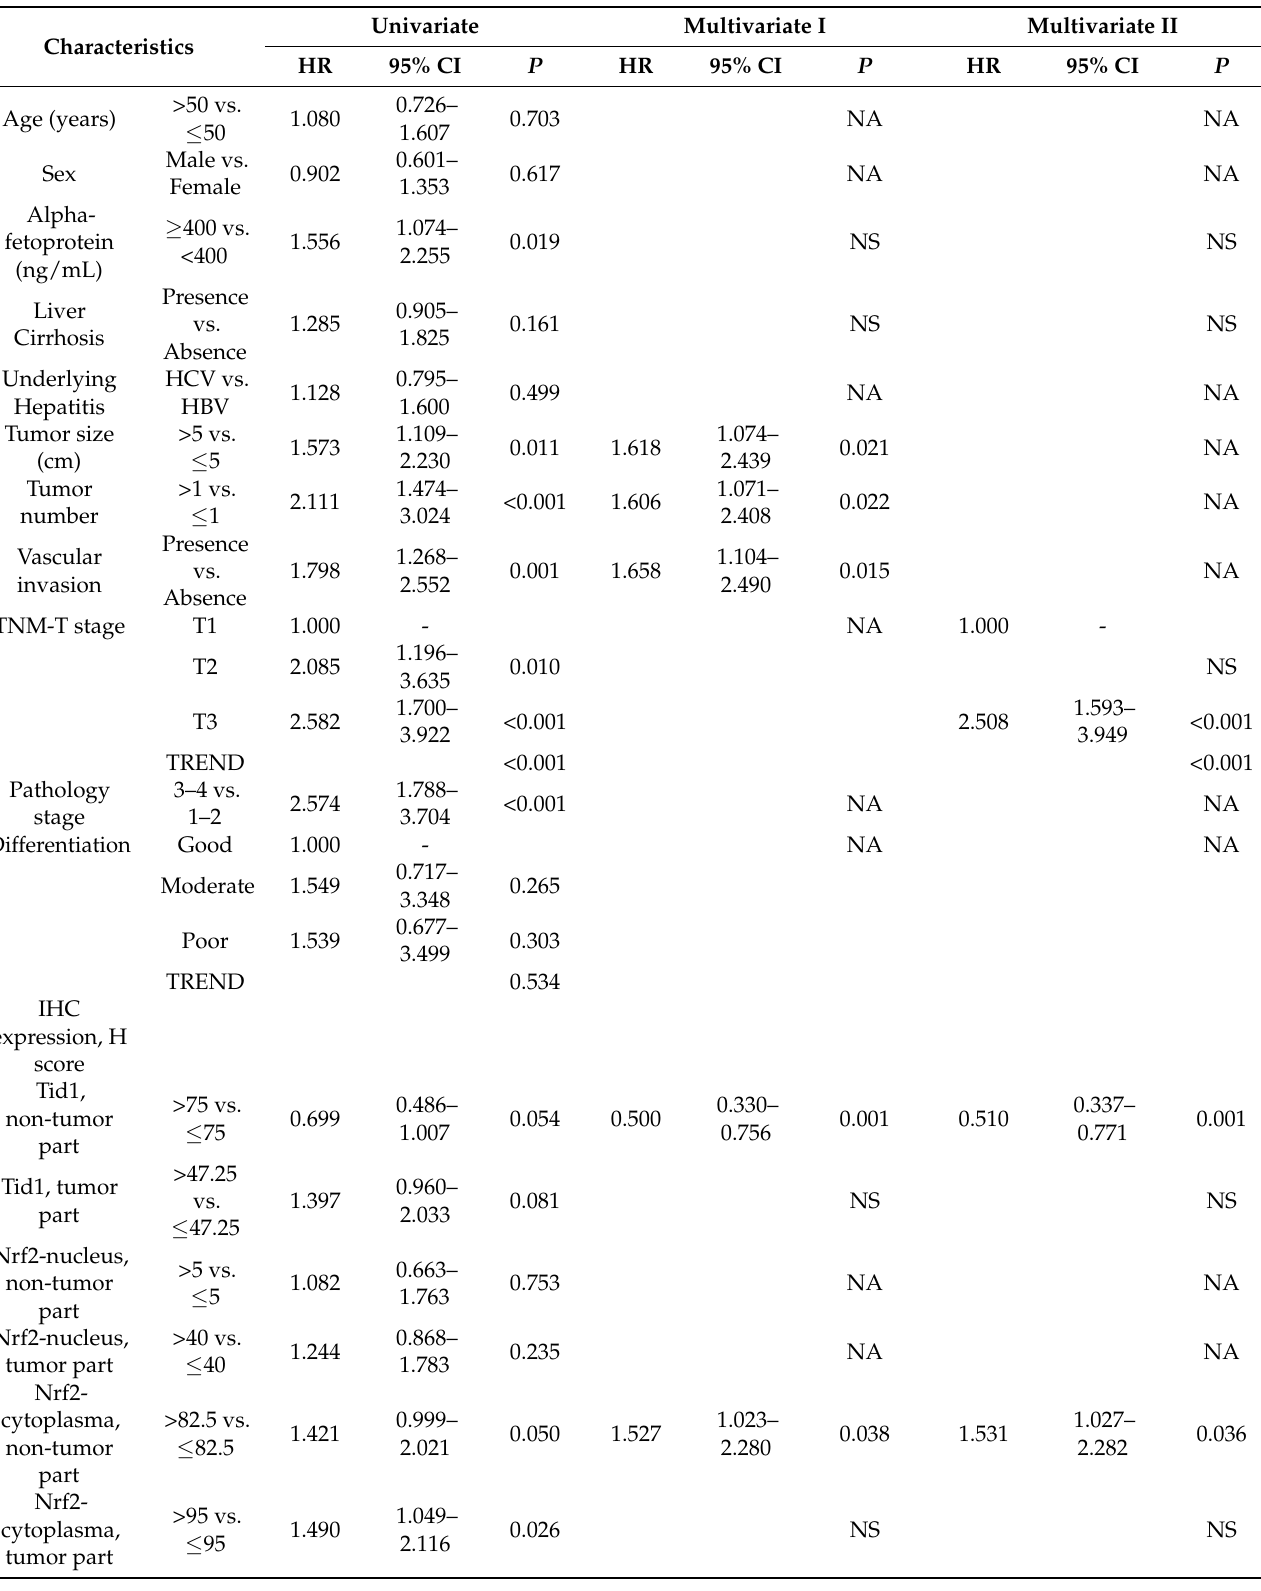
Table 6. Univariate and multivariate analyses of factors associated with recurrence-free survival in 210 HCC patients.